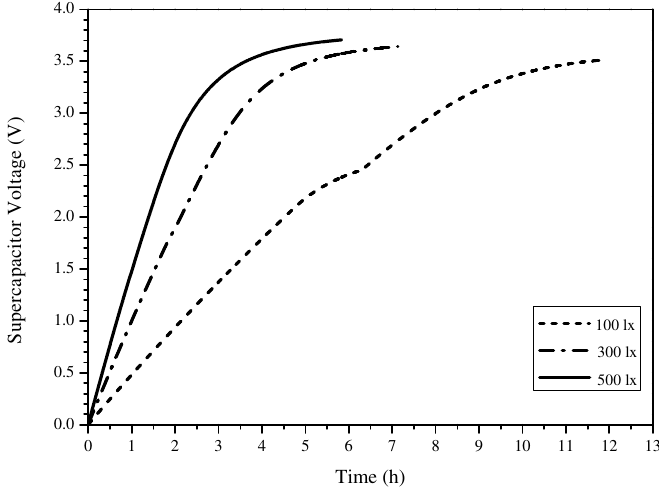
Figure 10. Backup storage charging curves at different illumination levels (incandescent light